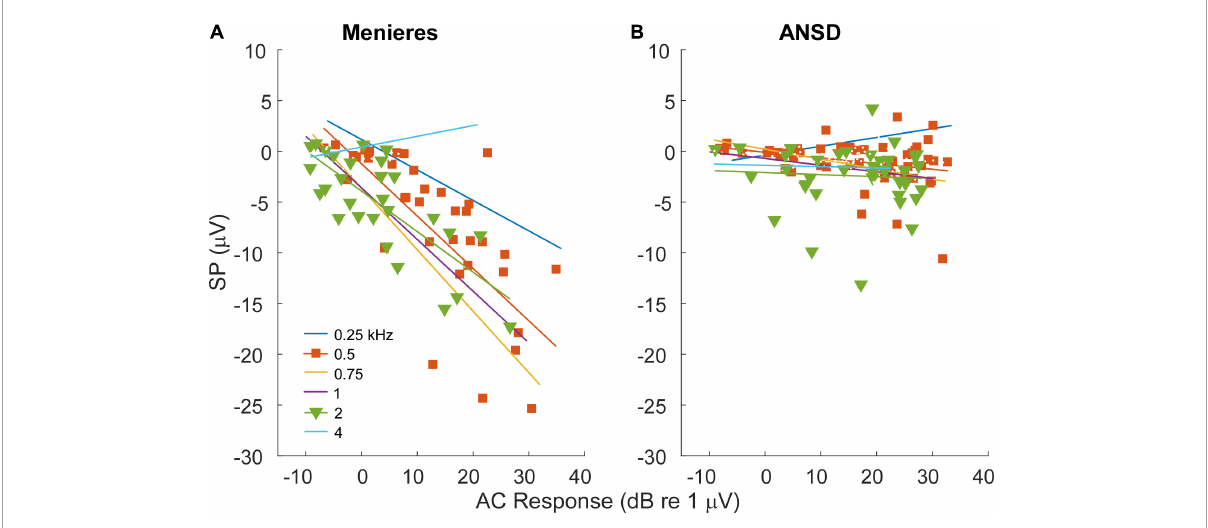
FIGURE4 Relationship between alternating current (AC) response and summating potential (SP) magnitudes in electrocochleography (ECochG) responses across all tested frequencies. (A) ECochG signals of subjects with Meniere’s disease (MD) demonstrated strong correlation between the magnitude of the AC response and the magnitude (negative polarity) of the SP in all frequencies except 4 kHz (see Table 1 ). (B) In subjects with auditory neuropathy spectrum disorder (ANSD), an increased size of the AC response showed much smaller trends, although in the same direction of an increase in a negative SP for all frequencies other than 4 kHz (see Table 1 ).